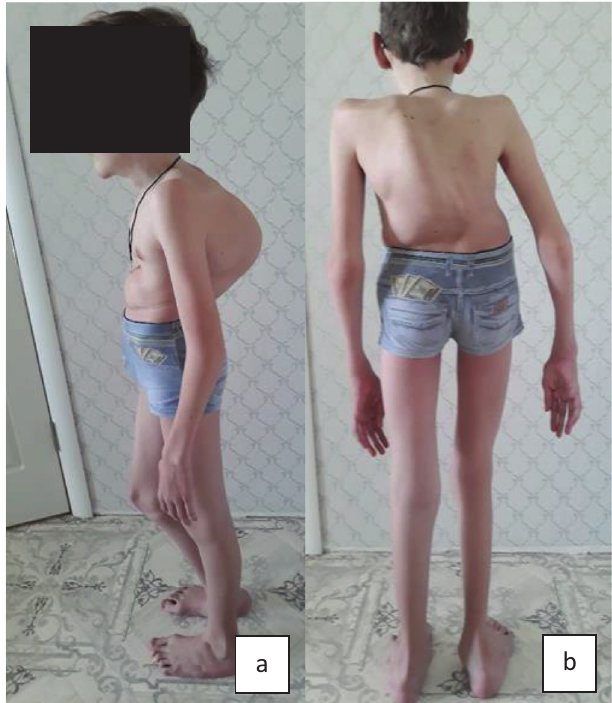
a b Figure 5. a) Proband no. 4: very low height and body mass (<3 percentile), thoracolumbar kyphoscoliosis of the 4 th degree, pectus excavatum of the 2 nd degree; b) Proband no. 4: thoracolumbar kyphoscoliosis of the 4 th degree, long thin limbs, pes planovalgus